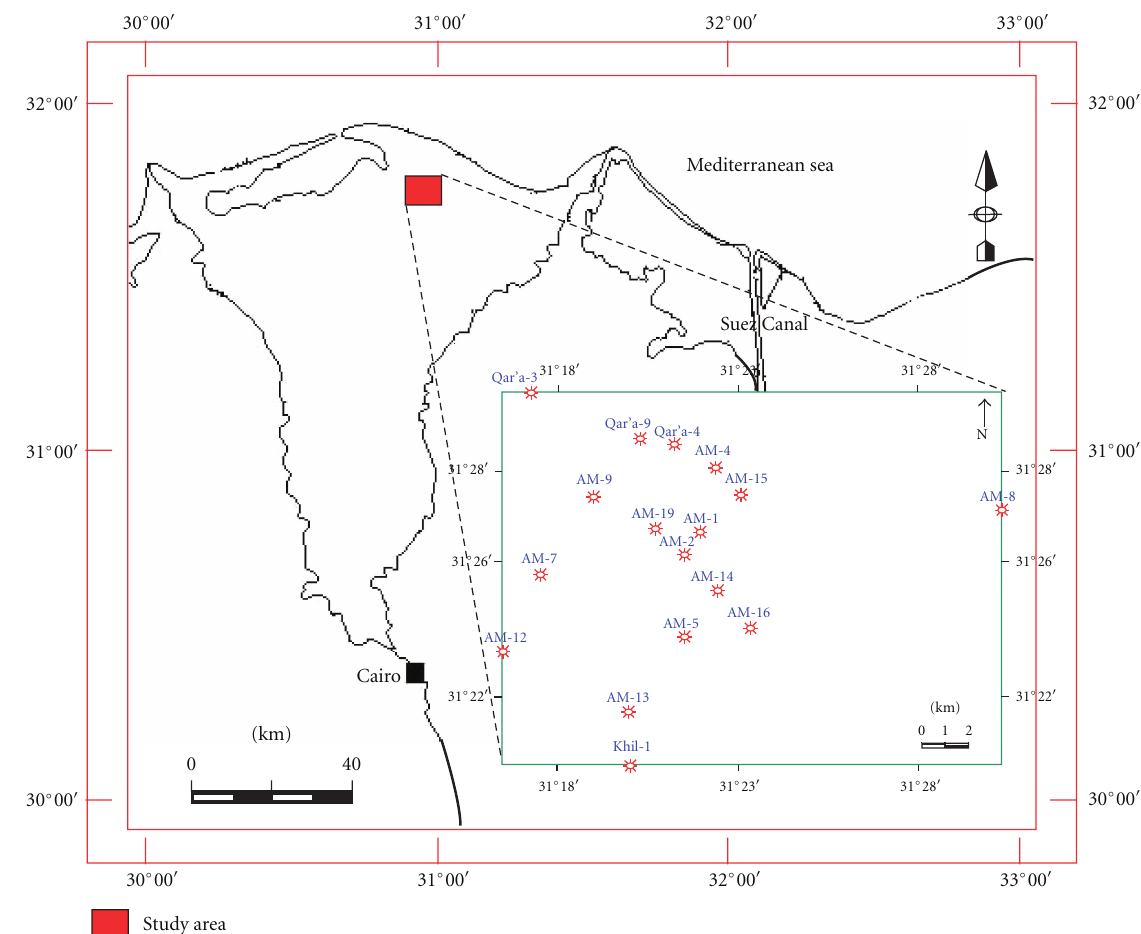
Figure 1: Location map of the study